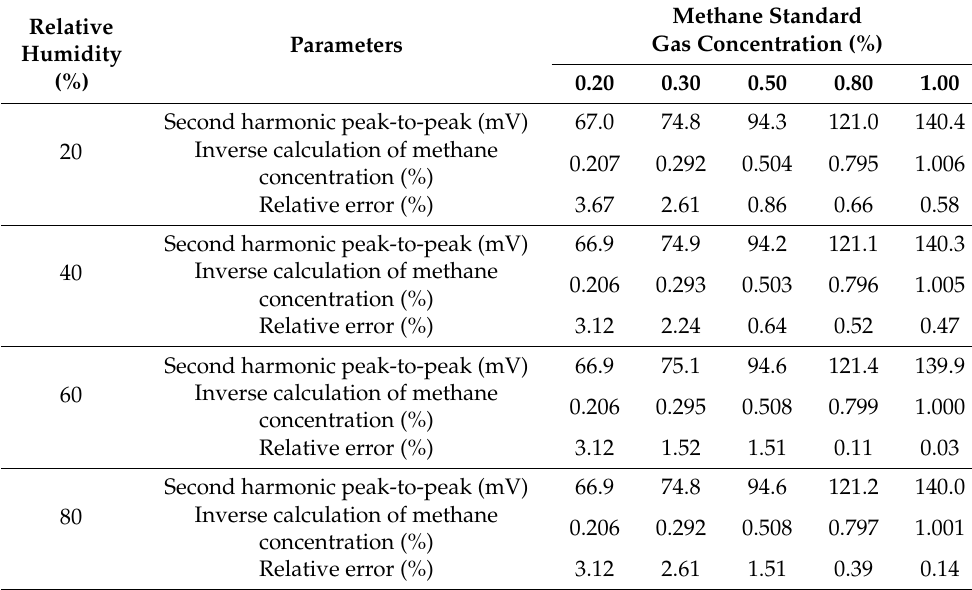
Table 6. Effect of humidity on methane